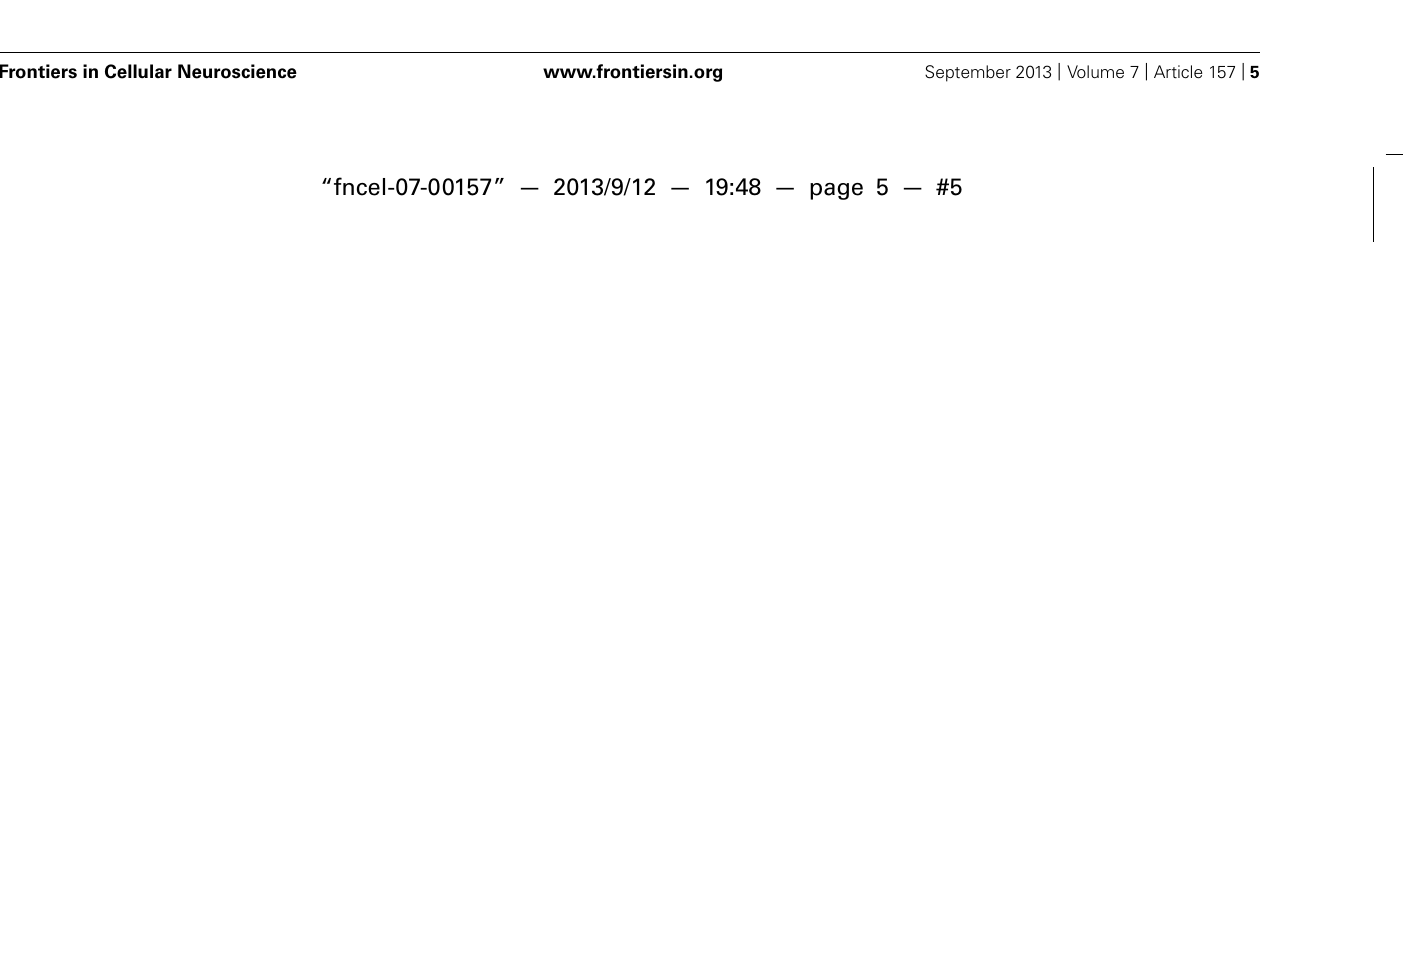
areas, due to different expression levels of specific DA receptors. See text for details. + , activation; − , inhibition; AC, adenylyl cyclase; β Arr, β -arrestin; cAMP, cyclic AMP; CaMKII, Ca 2 + /calmodulin-dependent kinase II; CREB, cAMP response element-binding protein DARPP-32, dopamine and cAMP-regulated phosphoprotein of 32 kDa; D1-5R, dopamine receptors (D1 to D5 subtypes); ERK, extracellular-regulated kinase; GSK-3 β , glycogen synthase kinase 3 β ; PKA, protein kinase A; PLC, phospholipase C; PP-1, protein phosphatase 1; PP2A, protein- phosphatase